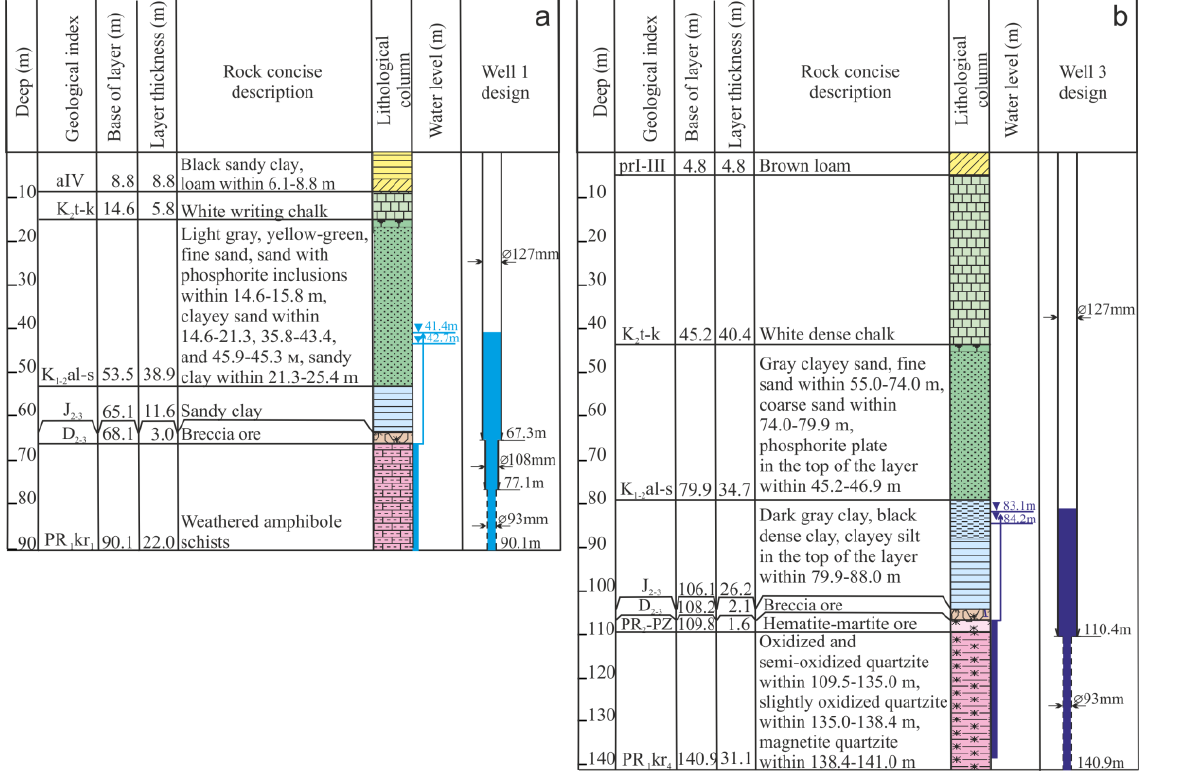
Figure 3. Diagrams of atmospheric pressure (a), relative groundwater levels U1 in well #1 (b) and 175 U3 in well #3 (c). Detailed data in February, 2022 for: box A – atmospheric pressure; box 176 B, C – relative levels (top panel) and levels without influence of atmospheric pressure (bottom panel, 177 blue) and without influence of atmospheric pressure and Earth’s tides (bottom panel, red). Level 178 U1 in well #1 – box B, level U3 in well #3 – box C.